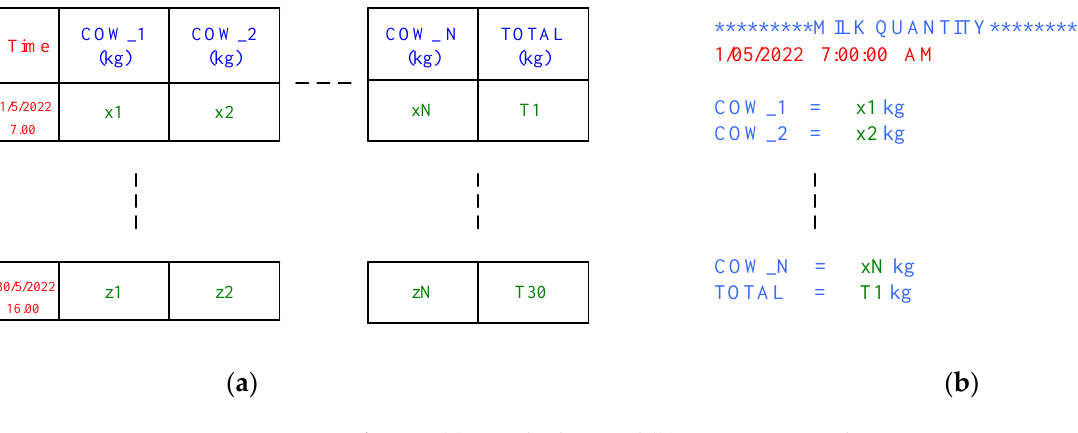
Figure 8. Data format: ( a ) Google sheet and ( b ) SD memory card.